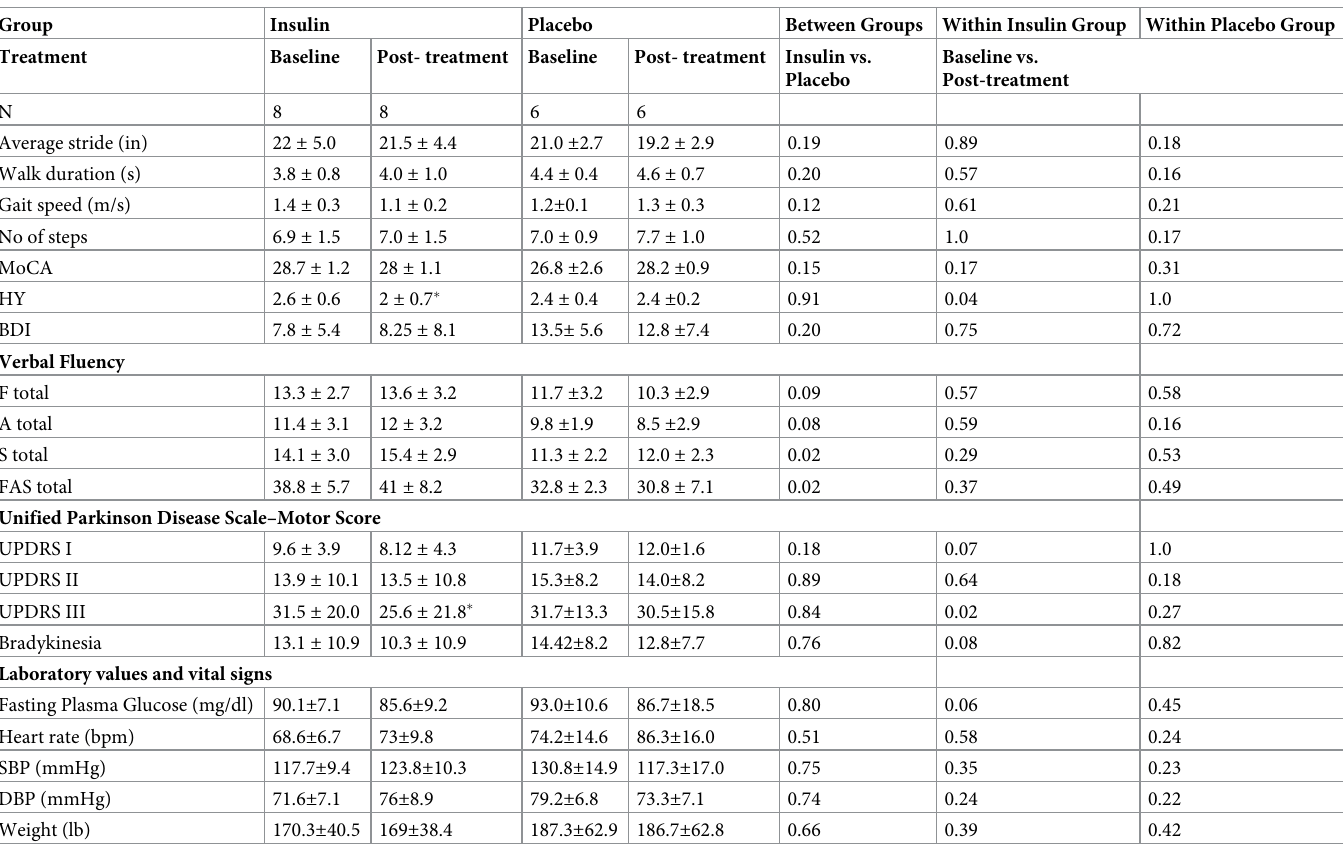
Table 2. Effects of intranasal insulin/placebo treatment on verbal memory, motor function and vital signs. Group Insulin Placebo Between Groups Within Insulin Group Within Placebo